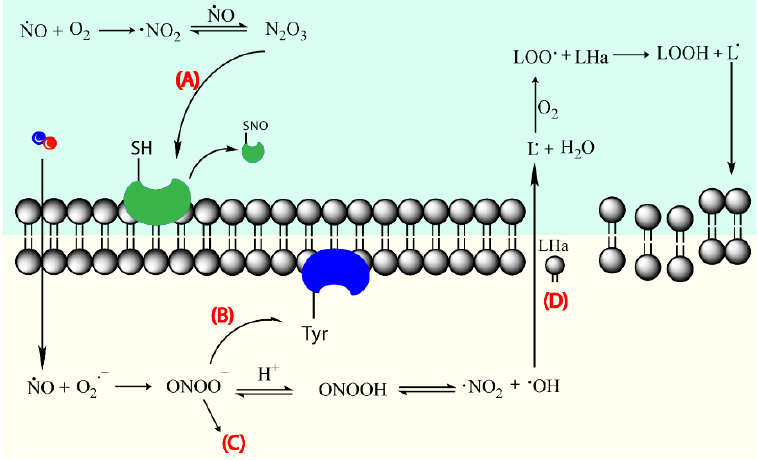
Figure 3. NO acting mechanism on bacteria cell membrane. Nitric oxide leads to thiol nitrosation ( A ), tyrosine nitration ( B ), DNA cleavage ( C ), and lipid peroxidation ( D ). Lipid (L) and allylic proton (Ha). Adapted with permission from Ref. [27]. Copyright {2021} American Chemical Society and Adapted with permission from Ref. [54]. Copyright {2008} American Chemical Society.